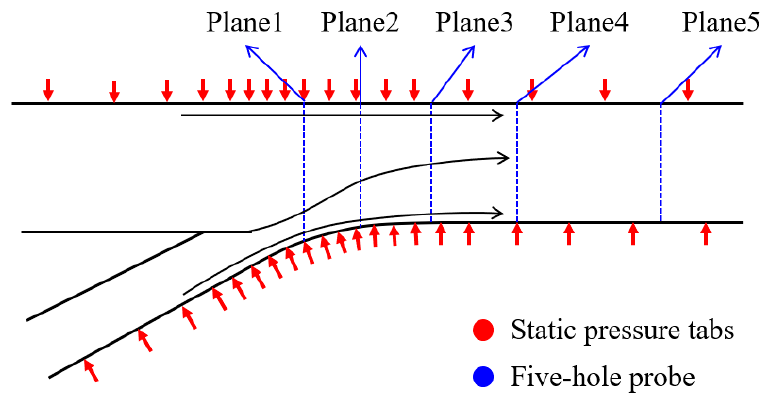
Figure 17. Measurement locations of the pneumatic probe.